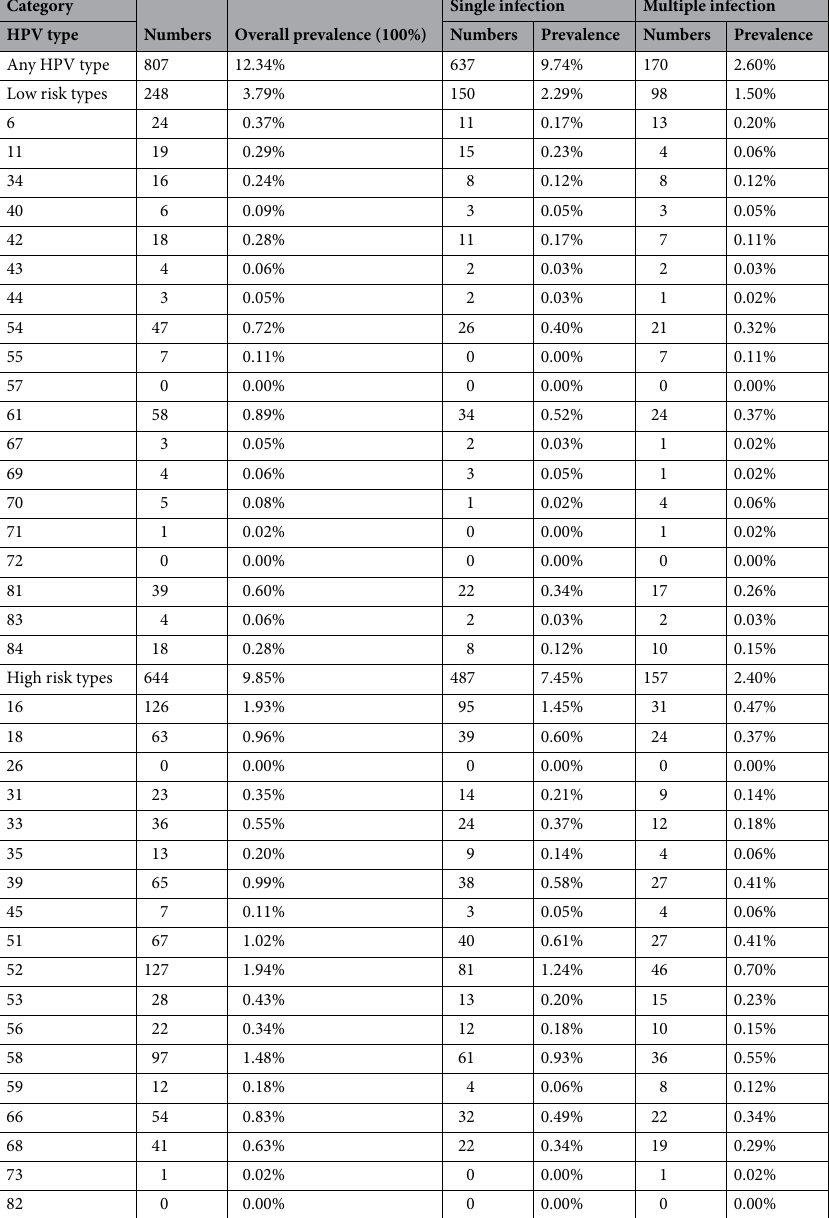
Table 1. The prevalence of 37 HPV genotypes of single/multiple infection in all the specimens (n =